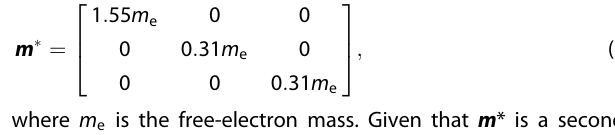
Fig. 4 Density of states of bandgap and bandgap isosurfaces. a Bandgap values achievable through ESE for various values of elastic strain energy density h within the strain space. The green shading of the region re fl ects the distribution of the available bandgap. The boundary of the strain region where a direct bandgap could occur is indicated by the red dashed line. The lowest h to achieve direct bandgap in diamond is about 20 meV/Å 3 . Inset is the visualization of the direct bandgap strain cases in 6D. Every strain state is represented here as a hexagon with vertices on the ε 11 ; ε 13 ; ε 33 ; ε 23 ; ε 22 ; ε 12 axes. Black webs correspond to random 6D strains; brown webs correspond to the direct bandgap strains generated by our ML model. The most energy-ef fi cient pathway to decrease the bandgap (i.e., the lower-bound function) and the upper bound of the attainable bandgap is denoted by the black dotted lines. b – d Bandgap isosurfaces in the ε 11 ε 22 ε 33 (normal only) strain space at 2 eV, 3 eV, and 4.25 eV levels, respectively. The carapaces ( Δ 1 ; Δ 2 ; and Δ 3 ), ridgelines ( r 1 ; r 2 ; and r 3 ), and corner ( μ ) are indicated in red, green, and purple letters, respectively. e Bandgap isosurface in the ε 23 ε 13 ε 12 (shear only) strain space at 3.5 eV. The yellow arrow indicates a change of carapaces on this isosurface pertaining to indirect-to-direct bandgap transition in the diamond. The corresponding change from the indirect bandgap structure to the direct bandgap structure of CBM k -space coordinates from X 1 (0, 0.5, 0.5) to Γ (0, 0, 0) is shown in band structure plots ( f ) and ( g ), respectively. Red arrows in both plots indicate the can be de fi ned in terms of the Hessian matrix H ( E n ( k )) consisting CB of second partial derivatives with respect to k . Based on the values drawn from our ML model, the electron effective mass m (cid:4) tensor for an undeformed diamond at CBM is extracted by fi tting the band structure: